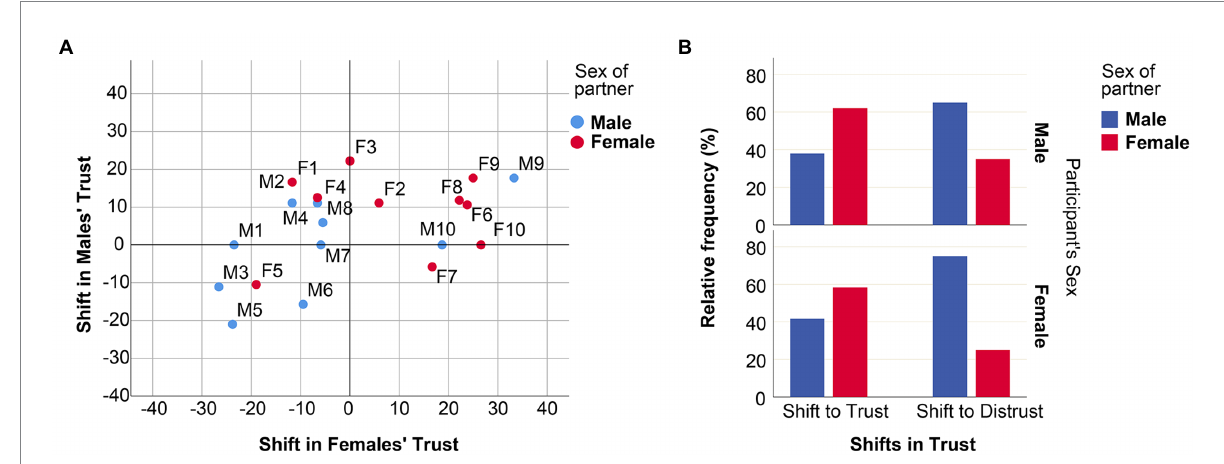
FIGURE 3 Shifts in trust decisions elicited by the 20 videos of interaction partners. (A) The graph depicts the average shift in trust in female (horizontal axis) and male (vertical axis) subjects elicited by each of the 20 videos of interaction partners (10 males, M1–M10, and 10 females: F1–F10). Negative scores indicate that showing the corresponding video reduced trust on average (in comparison to the trust level in the anonymous setting); positive scores indicate an increase in trust. (B) Relative frequency distributions of individual switches in (the binary) trust decision, in relation to the sex of the interaction partners in the Trust Game. N =